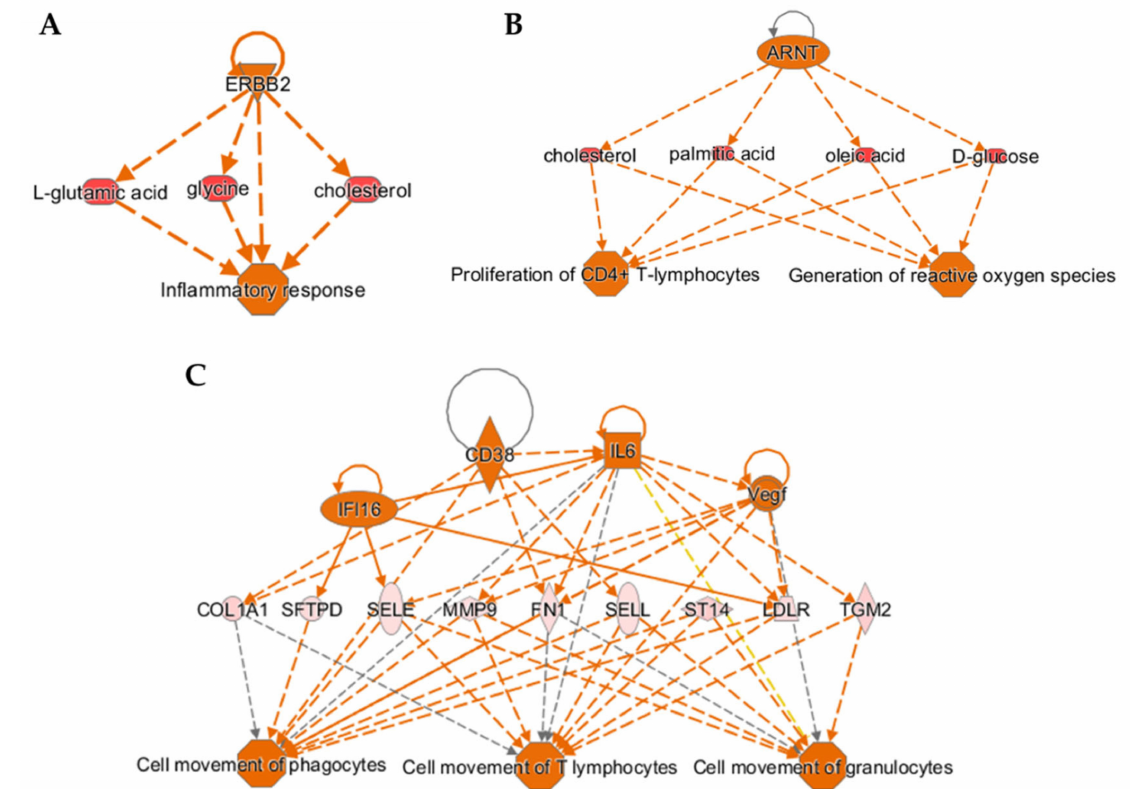
Figure 4. Cause-effect relationship analysis provides mechanistic insight into T1D pathogenesis based on integrated multi-omics datasets. ( A – C ) Three-tier diagrams (networks), predicted by the “Regulator Effects” analysis module in IPA software using the integrated quadra-omics dataset with decreasing stringency of feature selection threshold (i.e., fold-change cutoff). Each network shows the predicted upstream regulators (top row), selected molecules with significant differential expression as identified in the actual data (middle row), and the immune functions/processes predicted to be affected (bottom row). ( A ) A network that was consistently predicted at cutoff values of 1.1, 1.2, and 1.3 showing activation of the inflammatory response. ( B ) A network predicted at the cutoff values of 1.1 and 1.2 showing upregulation of CD4+ T-lymphocyte proliferation and ROS generation. ( C ) A network predicted only at the cutoff value of 1.1 showing activation of cellular movement of T-lymphocytes, granulocytes, and phagocytes. Marker key—Triangle: kinase; horizontal-oval: transcription regulator; vertical-oval: transmembrane receptor; diamond: enzyme; square: cytokine; horizontal ellipse: metabolite; circle: other; octagon: function. Color key—orange: predicted activation, blue: predicted inhibition. Connecting line color key—orange: activation; blue: inhibition; and gray: not